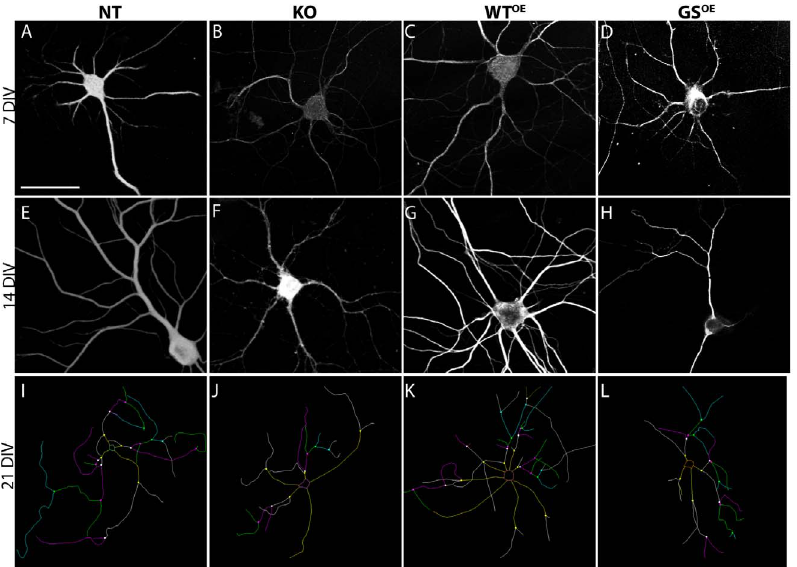
Figure 2. Dendrites from all genotypes grow and arborize over the course of three weeks. Confocal images of MAP2 immunolabeled neurons at 7 DIV (A–D) and 14 DIV (E–H). Magnification bar=50 m m. These and similar preparations were traced in their entirety using Neurolucida. (I–L) Examples of such tracings are shown for 21 DIV neurons. Color-coding of dendrite branches corresponds to branch order. The maps shown are not to scale, but have been sized to fit the frame.